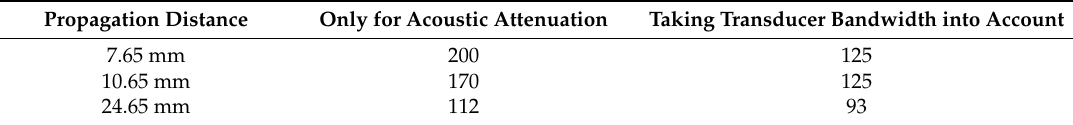
Table 1. Truncation frequency ω cut / ( 2 π ) in MHz.